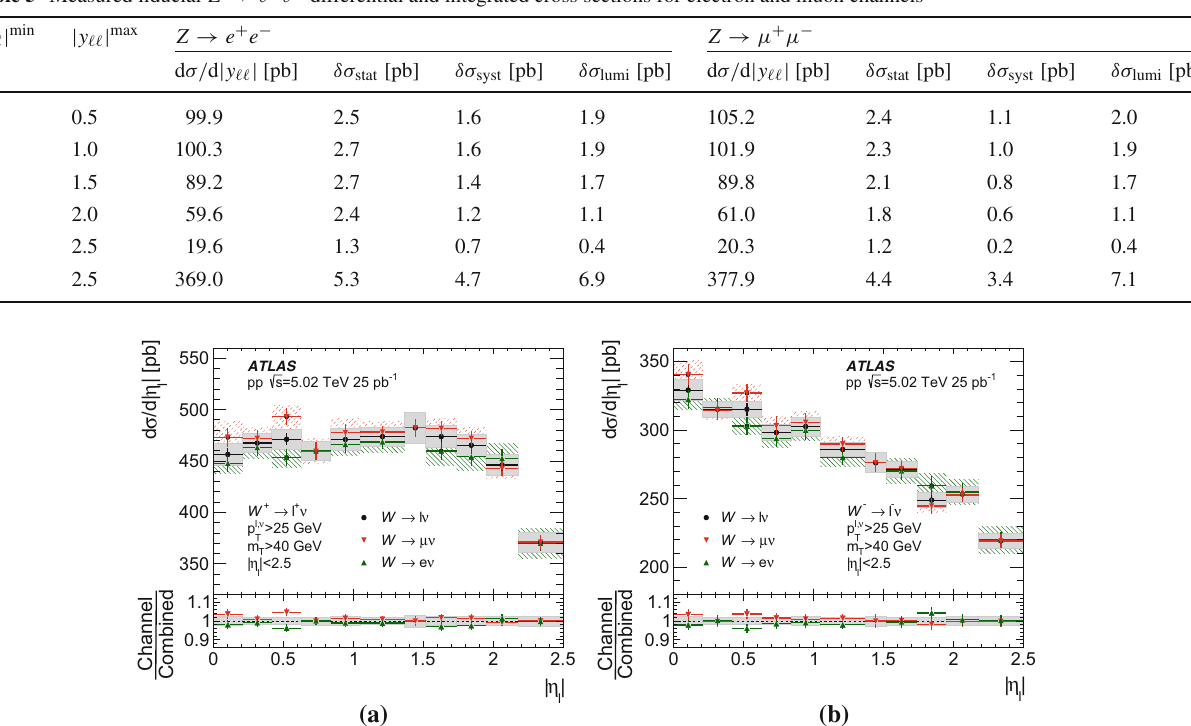
Fig. 8 Differential a W + and b W − boson production cross sections as a function of absolute decay lepton pseudorapidity, for the electron, muon and combined results. Statistical and systematic errors are shown as corresponding bars and shaded bands. The luminosity uncertainty is not included. The lower panel shows the ratio of channels to the com-